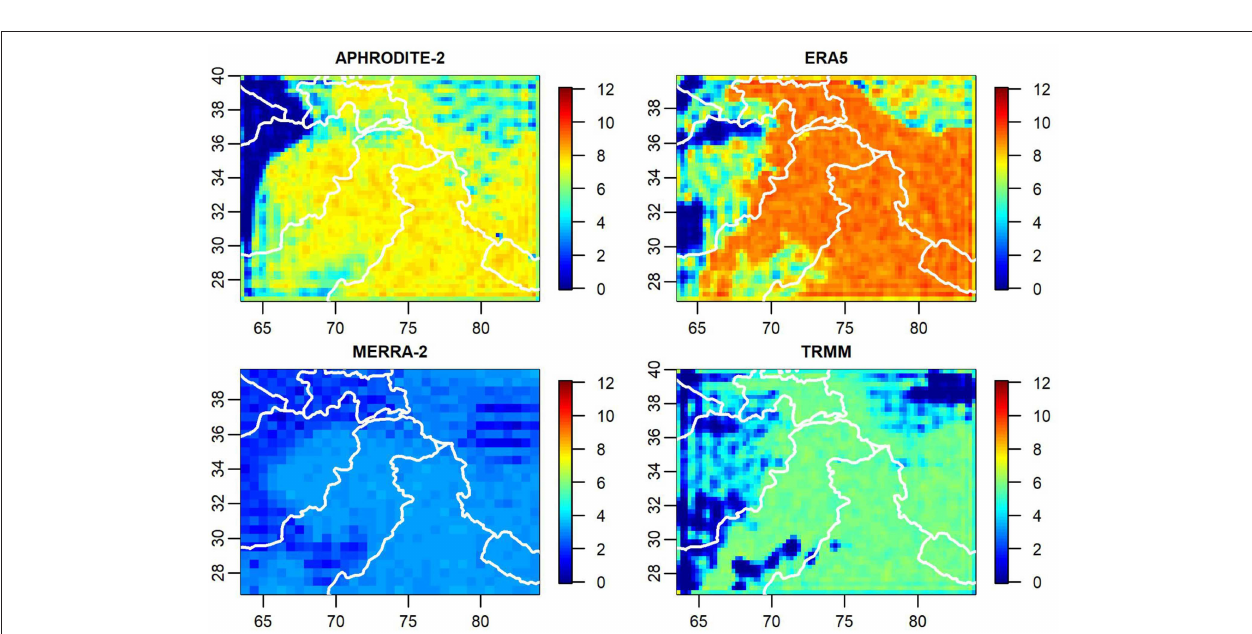
FIGURE 5 | Discrepancy surfaces for August 2000 (in mm). Red regions indicate areas where the product modeled higher precipitation than shared surface, while blue regions indicate lower precipitation relative to shared surface.